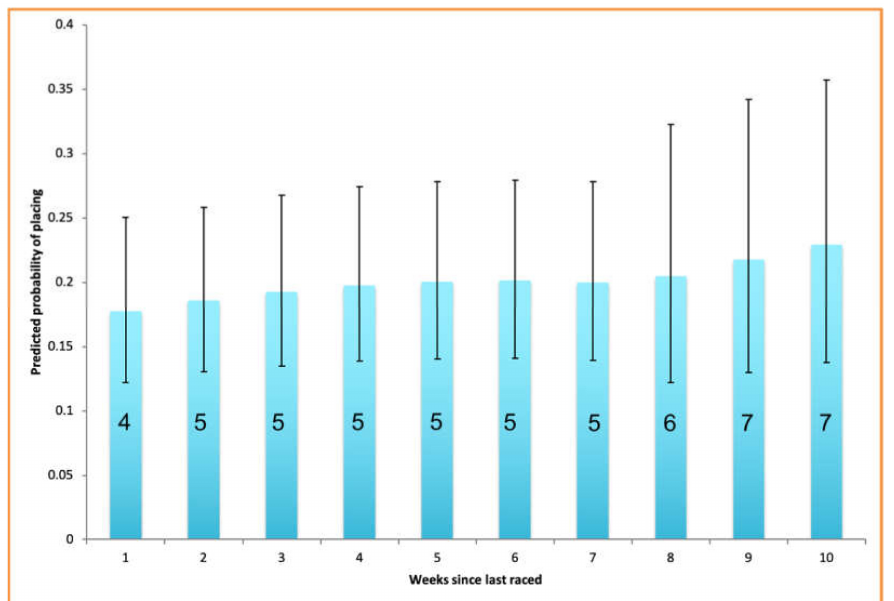
Figure 2. Predicted placings of male dogs 1–10 weeks after since last racing. Placings with the highest probability when all other factors in the ordinal linear regression model are held at their mean are shown on the bars. Error bars show the upper limits and lower limits of predicted probabilities associated with the placings. Thus, there is a predicted loss of three places between racing male dogs a week after their last race compared to 10 weeks after their last race.